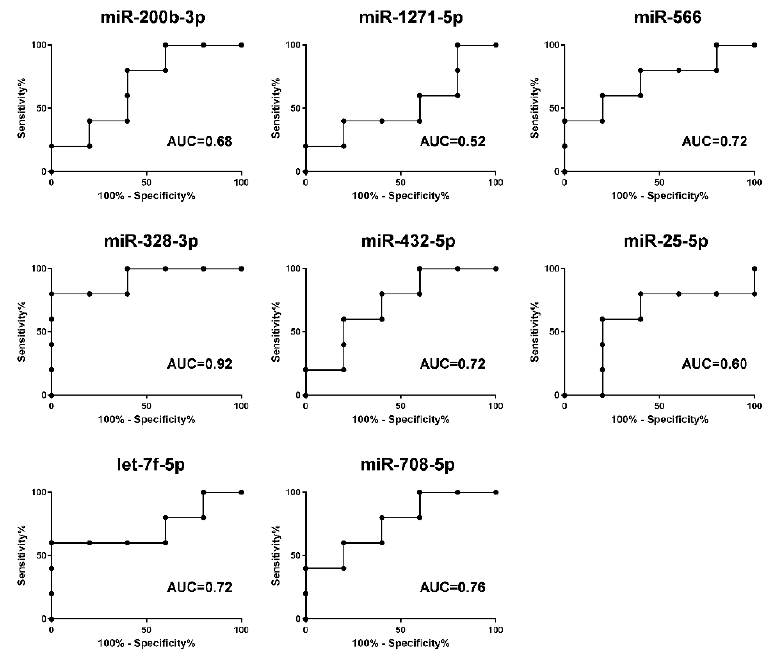
Figure 7. ROC curves of the diagnostic potential of the individual blood miRNAs (miR-200b-3p, miR-1271-5p, miR-566, miR-328-3p, miR-432-5p, miR-25-5p, let-7f-5p and miR-708-5p) after 14 days of ECMO support discriminating between group A and group B patients. ROC curves were made with values of relative expression of each miRNA at 14 days of ECMO support. The area under curve (AUC) values ranged from 0.52 to